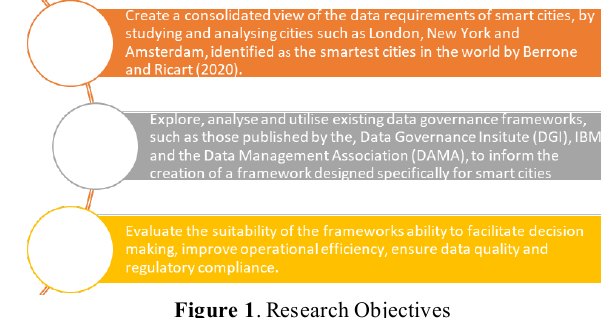
Figure 1 . Research